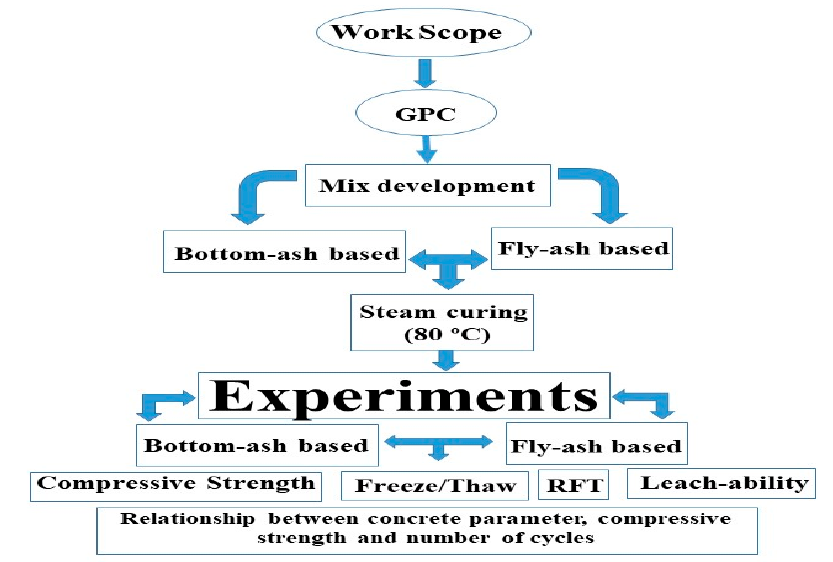
Figure 3. The work scope of the current study.